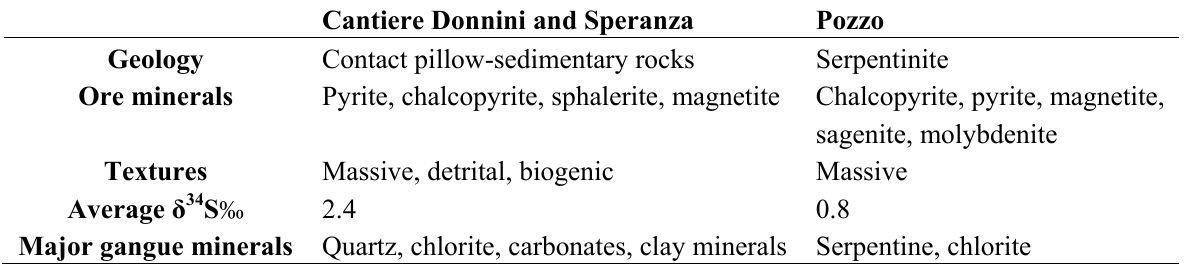
Table 1. Characteristics of the Corchia